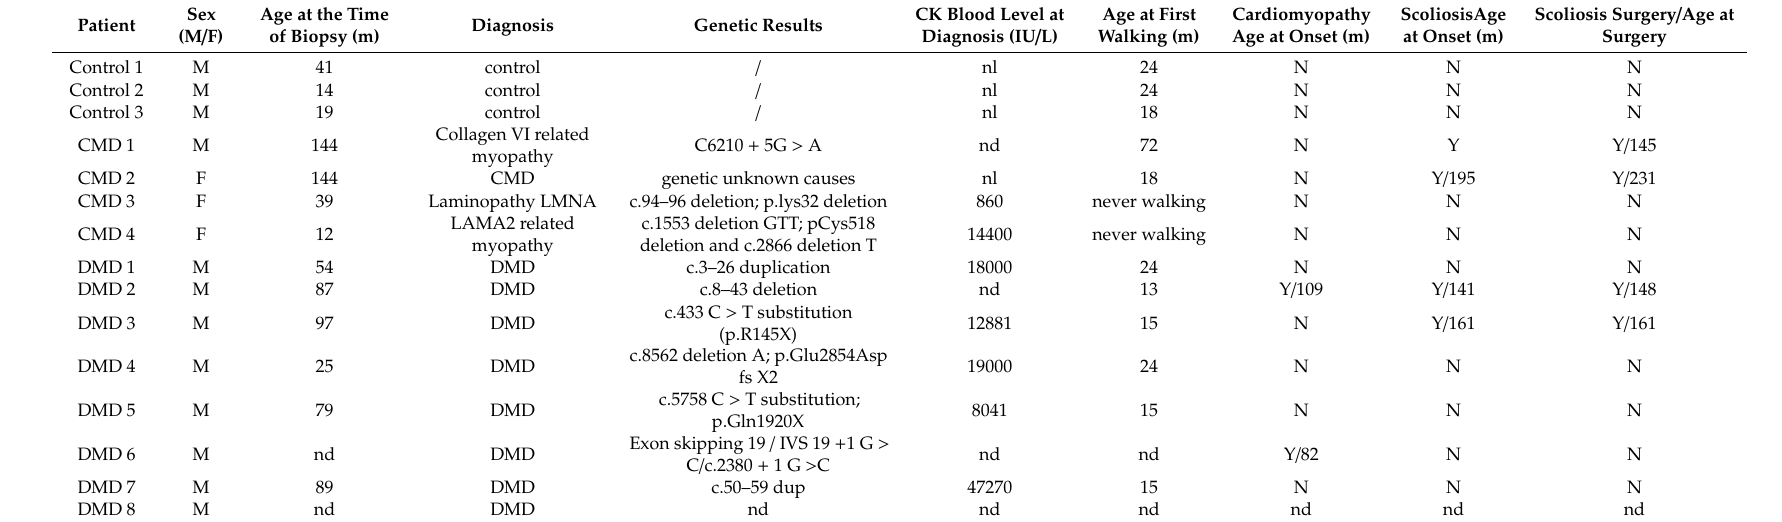
Table 2. Clinical data of